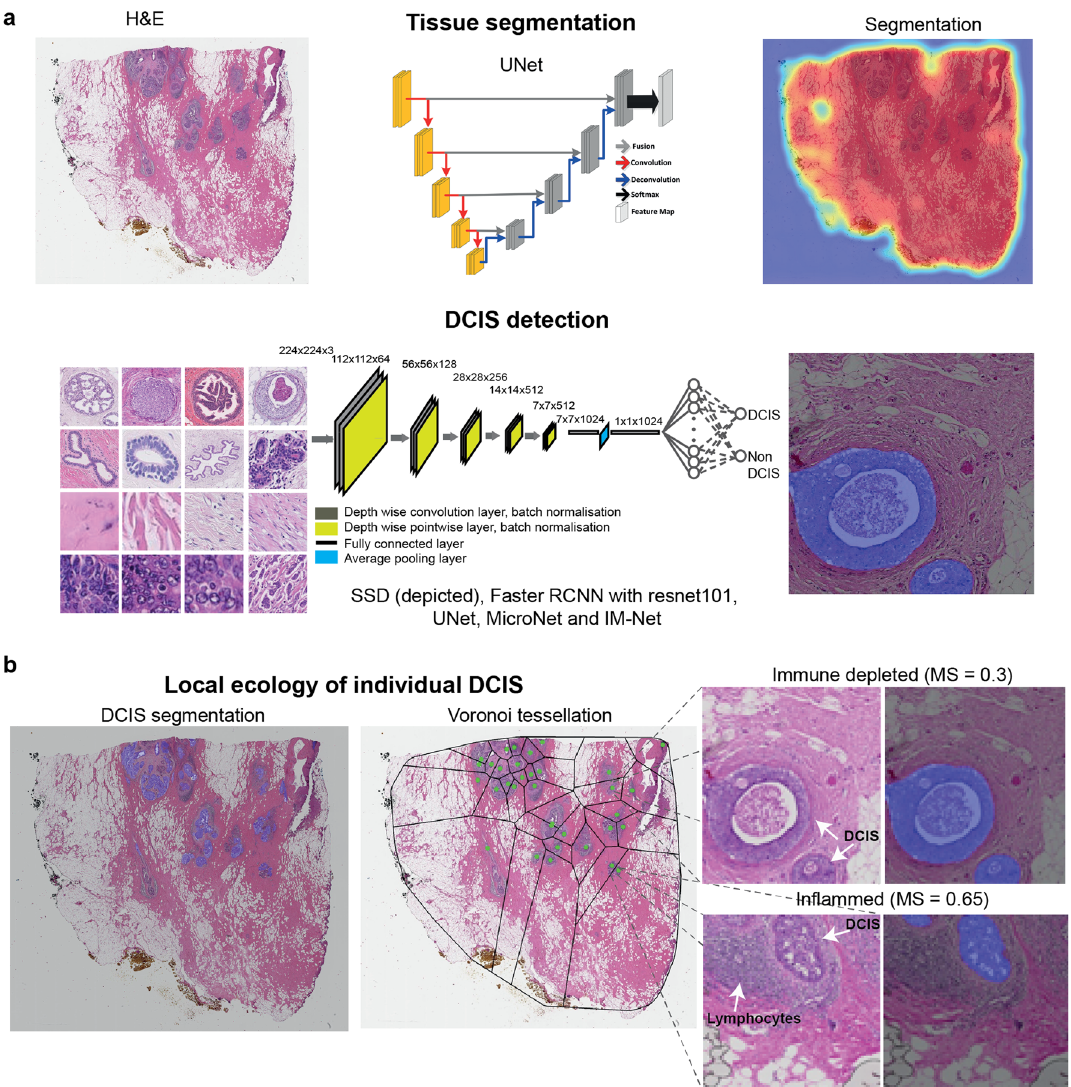
Fig. 1 Overview of proposed UNMaSk pipeline for DCIS detection and segmentation. a UNet architecture for tissue segmentation and one of the existing deep learning methods, single-shot detector (SSD) architecture, used for DCIS detection. b Spatial Voronoi tessellation to examine local tissue ecology for each DCIS duct, based on deep learning results on DCIS segmentation and single-cell classi fi cation. Examples shown are immune depleted and immune predominant/in fl amed ecology local to individual DCIS ducts and spatial analysis using DCIS immune colocalisation/Morisita Score